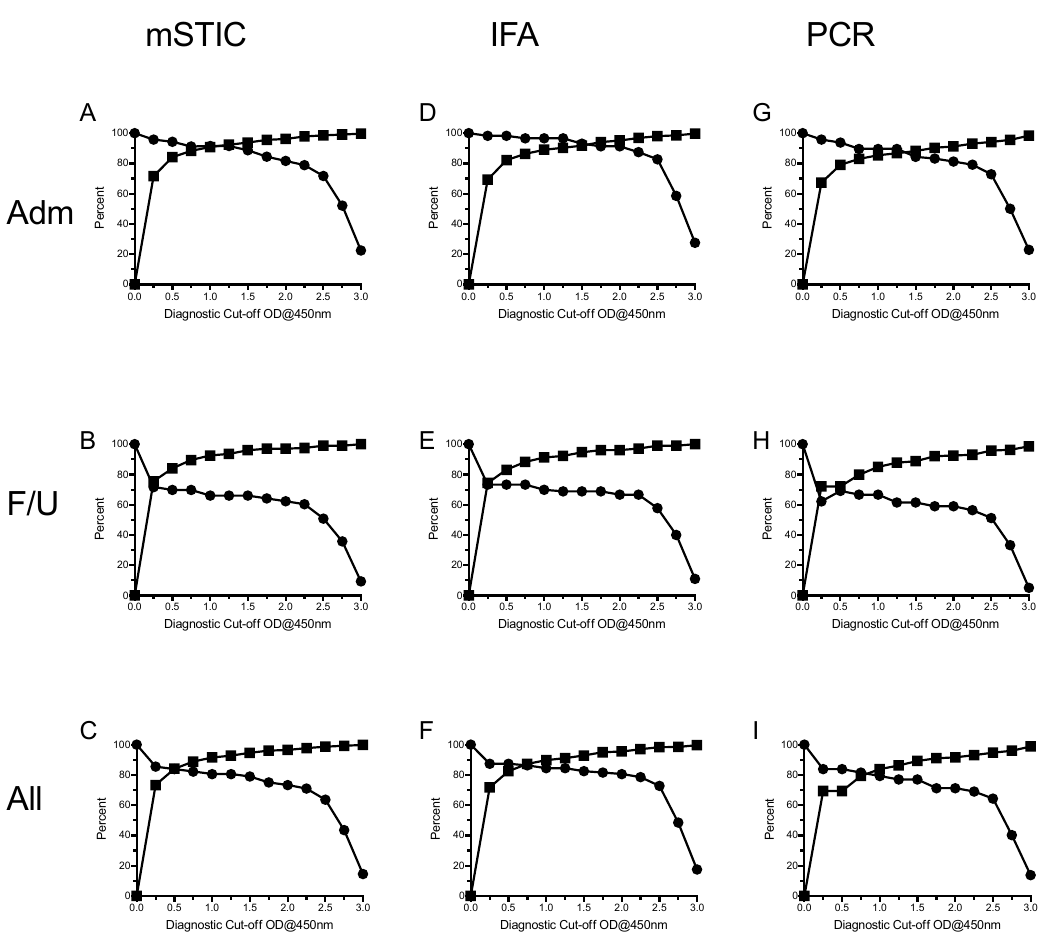
Figure 2. Sensitivity ( ) and specificity ( (cid:4) ) at a range of diagnostic cut-off values for the scrub typhus IgM ELISA when compared to the reference modified scrub typhus infection criteria (mSTIC), IFA, and PCR scrub typhus diagnosis for admission (Adm- A , D , G ), convalescent (F/U- B , E , H ), and all samples ( C , F , I ).